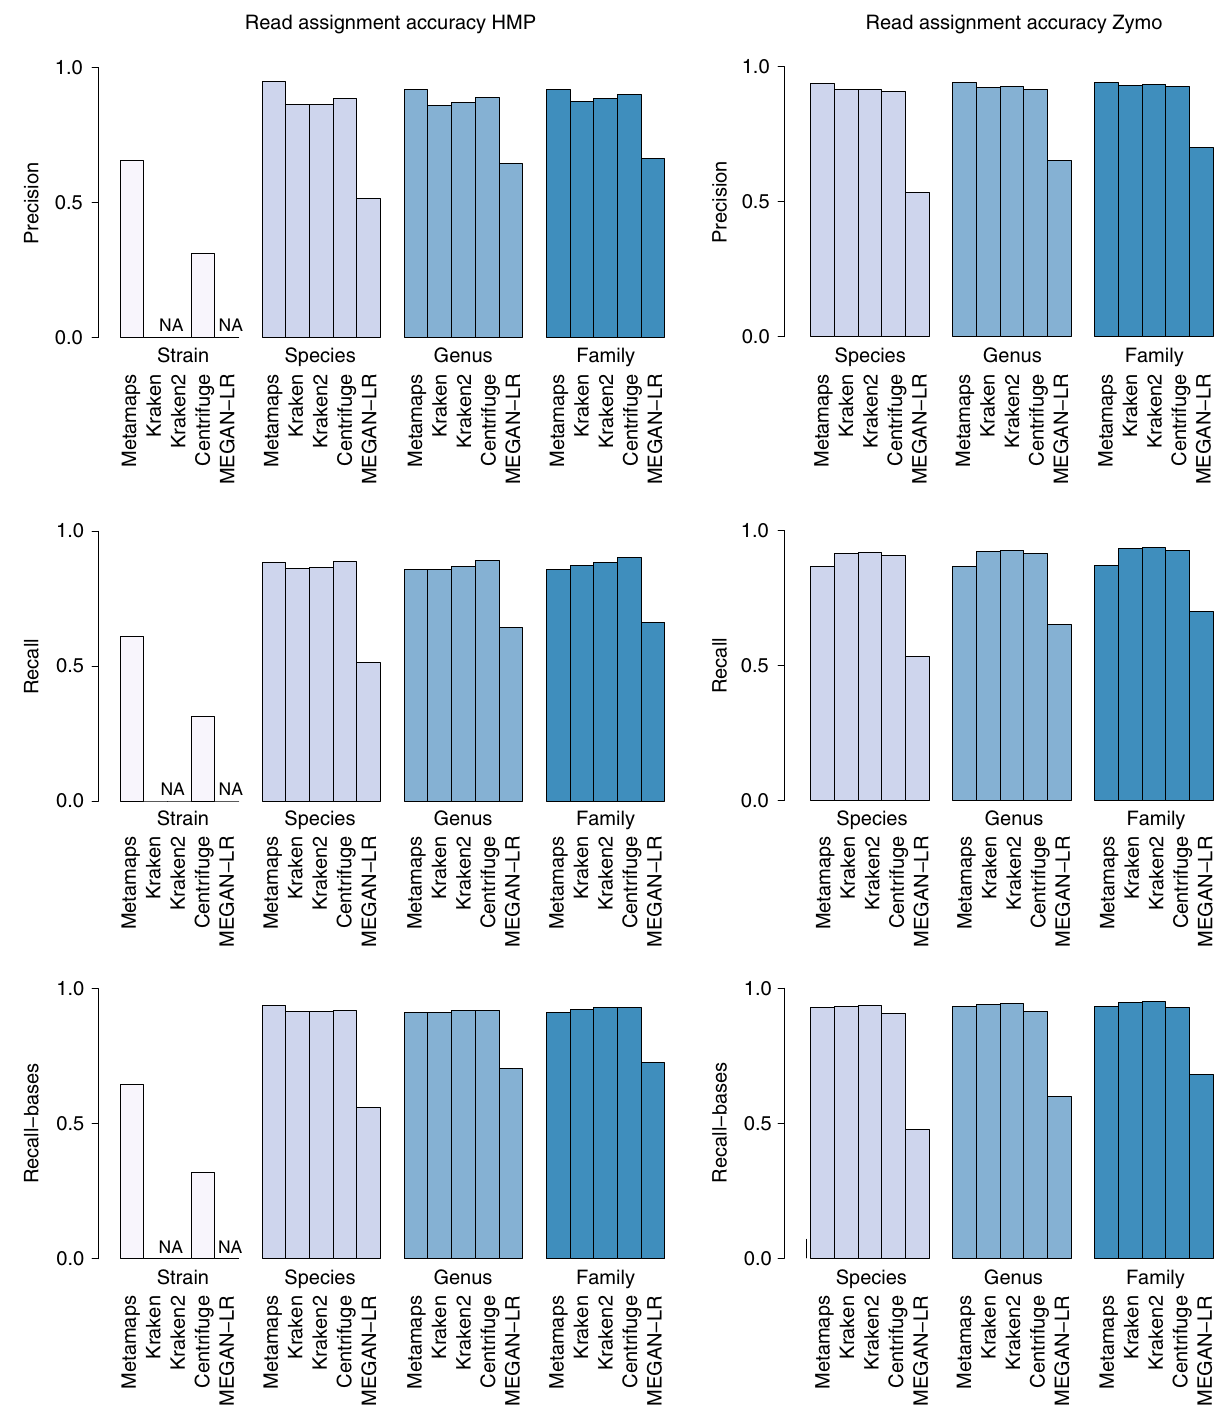
Fig. 4 Read assignment accuracy in experiments with real PacBio (HMP) and Nanopore (Zymo) data. Bar plots show precision, recall (read level), and recall (base level) for MetaMaps, Kraken, Kraken 2, Centrifuge and LAST + MEGAN-LR at different evaluation levels. Note that Kraken, Kraken 2 and MEGAN-LR were not designed to achieve strain-level resolution and therefore these tools are not evaluated at this